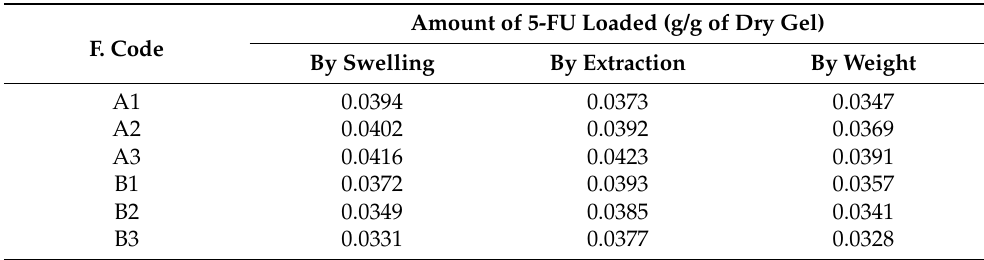
Table 4. Amount of 5-Flurouracil loaded in different formulations of acrylamide/acrylic acid hydrogels. F.